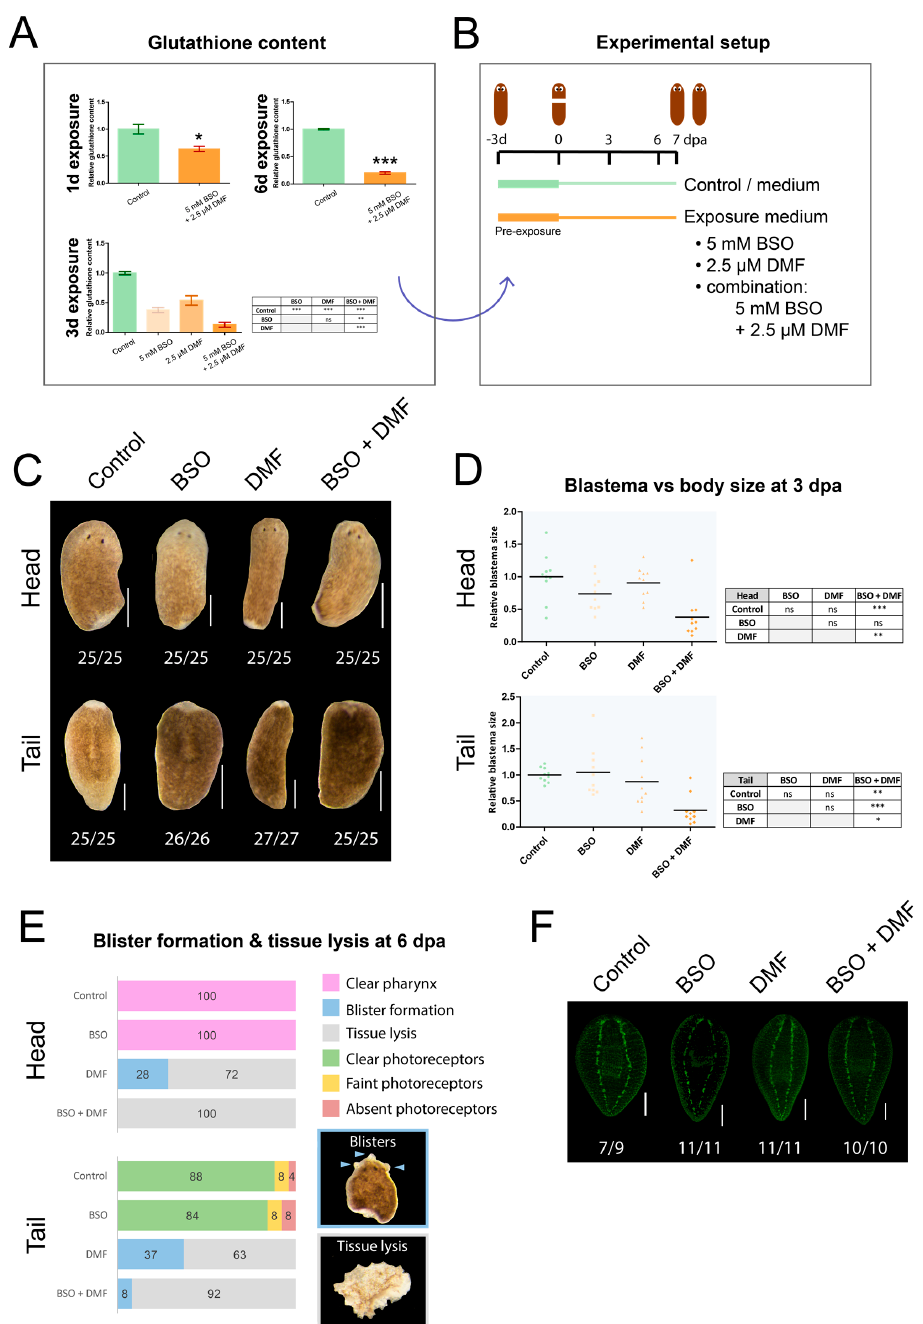
Figure 4. Glutathione content and phenotypes after interfering with the redox balance by exposure to redox-influencing compounds. ( A ) Average glutathione content in intact animals after exposure to 5 mM BSO and 2.5 µM DMF for 1, 3 or 6 days ( n = 4, * p < 0.05, ** p < 0.05, *** p < 0.001, error bars represent standard error). ( B ) Overview of the experimental setup for panel C–E: worms were pre-exposed for 3 days to 5 mM BSO, 2.5 µM DMF or a combination of both. Next, they were amputated in head or tail fragments and allowed to regenerate in the same exposure solutions. ( C ) Phenotypes 3 dpa after exposure to glutathione interfering compounds. The numbers below the worms represent how many times the depicted phenotype is observed versus the total number of observations. Scale bar represents 500 µm. ( D ) Blastema sizes normalised to the body size in head and tail fragments, relative to the control, 3 dpa (ns: not significant, * p < 0.05, ** p < 0.01, *** p < 0.001, black line represents average per condition). ( E ) Percentages of worms that form blisters and undergo tissue lesions in 6 dpa head and tail fragments. ( F ) Neuro- development in 5 dpa tail fragments, stained by anti-synapsin. Scale bar represents 200 µm. The numbers below the worms